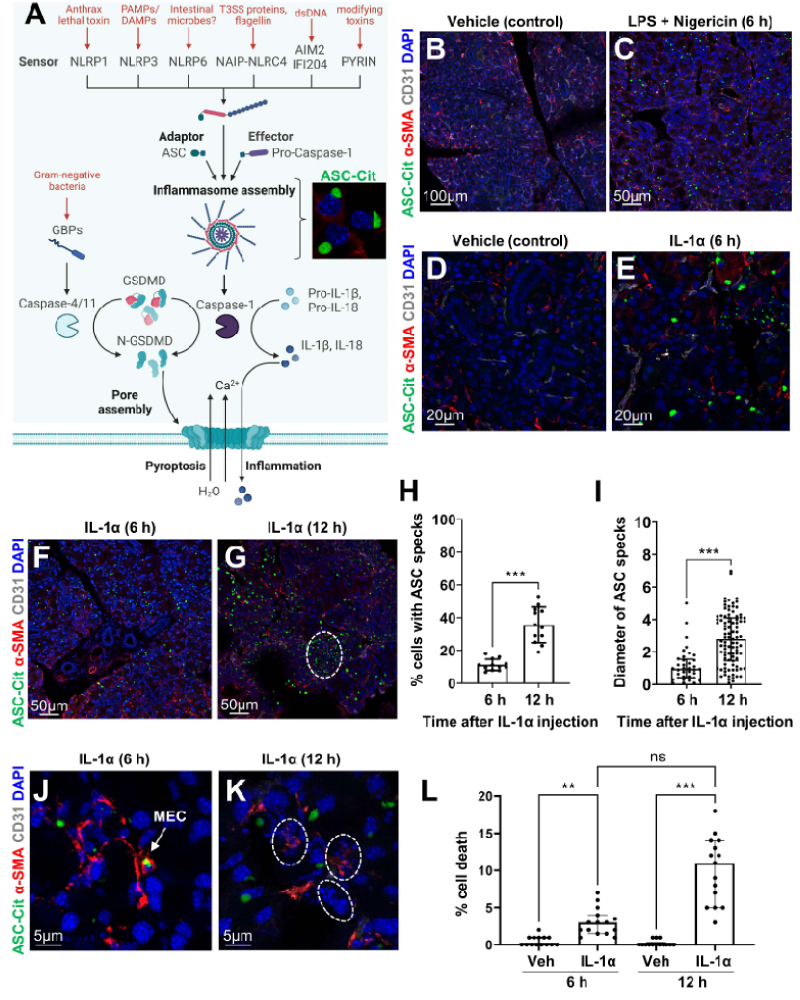
Figure 1. Microbial and sterile stimuli induce the assembly of canonical inflammasome in LG epithelial cells. ( A ) Overview of the inflammasome pathway. Depending on the PAMP/DAMPs (pathogen/damage-associated molecular patterns) detected, a specific inflammasome sensor will oligomerize and recruit the adaptor protein ASC (apoptosis-associated speck-like protein containing a CARD) and the effector pro-caspase-1 to form the canonical inflammasome complex. Inflammasome formation in the LG can thus be monitored in vivo using the R26 ASC-citrine reporter mouse forming green, fluorescent ASC specks (see micrograph). After auto-activation, caspase-1 cleaves gasdermin D (GSDMD) and the precursors for interleukins IL-1 β and IL-18. Guanylate-binding proteins (GBPs) activate caspase-4/11, which also cleaves GSDMD. The N-terminus of GSDMD then forms a pore at the plasma membrane, thus enabling the release of mature IL-1 β and IL-18, and the entry of water and calcium. This induces pyroptosis through cell swelling and calcium-dependent activation of calpains. Created with BioRender.com. ( B – L ) LG sections were analyzed for ASC specks formation (green) and immunostained for α -SMA (red) and CD31 (grey) to visualize MECs and blood vessels, respectively. R26 ASC-citrine mice ( n = 3 per group) were injected with ( B , D ) vehicle control, ( C ) LPS + nigericin, or ( E – L ) IL-1 α , and harvested at ( C , E , F , J ) 6 h or ( G , K ) 12 h after injury. ( G ) Dashed circle indicates immune infiltrates. ( H ) Percentage of cells displaying ASC specks after IL-1 α injection (mean (SD), unpaired t -test). ( I ) Size of specks increased over time after IL-1 α injection (median (IQR), Mann- Whitney test). ( K ) Dashed circles indicate nuclei fragmentation during cell death. ( L ) Proportion of dying cells after IL-1 α injection (Median (IQR), Kruskal-Wallis test). Significant differences are represented as ** if p < 0.01, and *** if p < 0.001; “ns” indicates non-significant